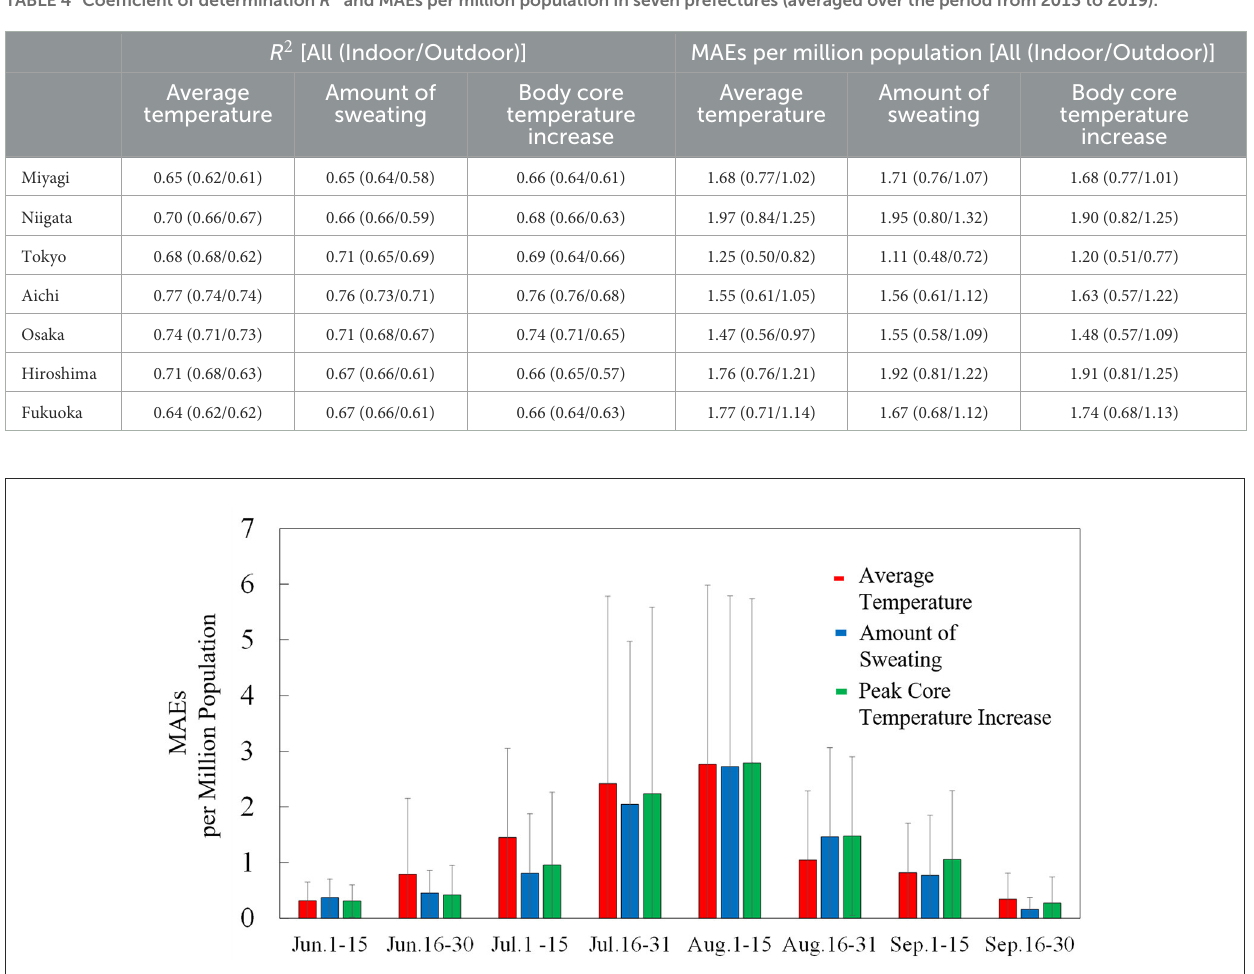
FIGURE5 Time series of MAEs per million population in Tokyo for average ambient temperature, amount of sweating, and body core temperature increase (averaged over the period from 2013 to 2019). Standard deviations are indicated by error bars.